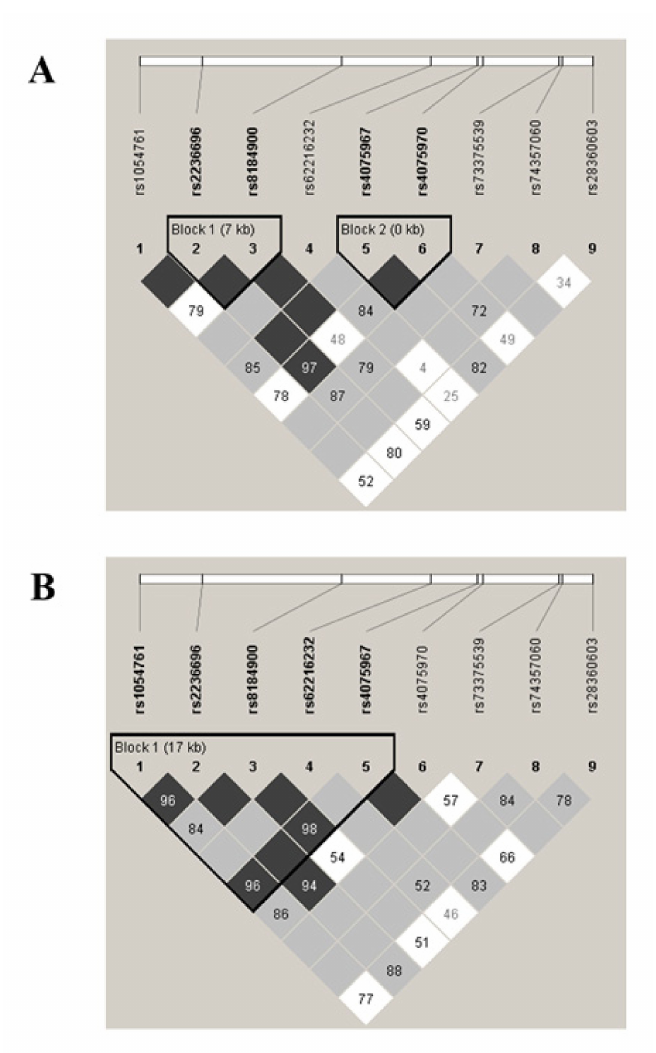
Figure 3. Linkage disequilibrium plots around the PRDM15 gene in the lower ( A ) and higher ( B ) proportion of Mapuche ancestry (PMA) groups. Squares represent the linkage disequilibrium (D’) value between every two single nucleotide polymorphisms: the darker the square, the higher D’ value. The five triangular shapes surrounding these markers indicate the haplotype blocks that were defined using the confidence interval